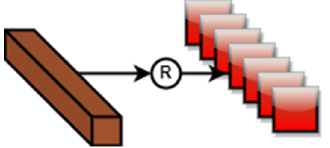
Figure 9. The Framework of Geno2Dblock. The activation value of the 2D convolution in the Geno2Dblock at the i (cid:2930)(cid:2918) layer at spatial position (x, y) in the j (cid:2930)(cid:2918) feature map is given by